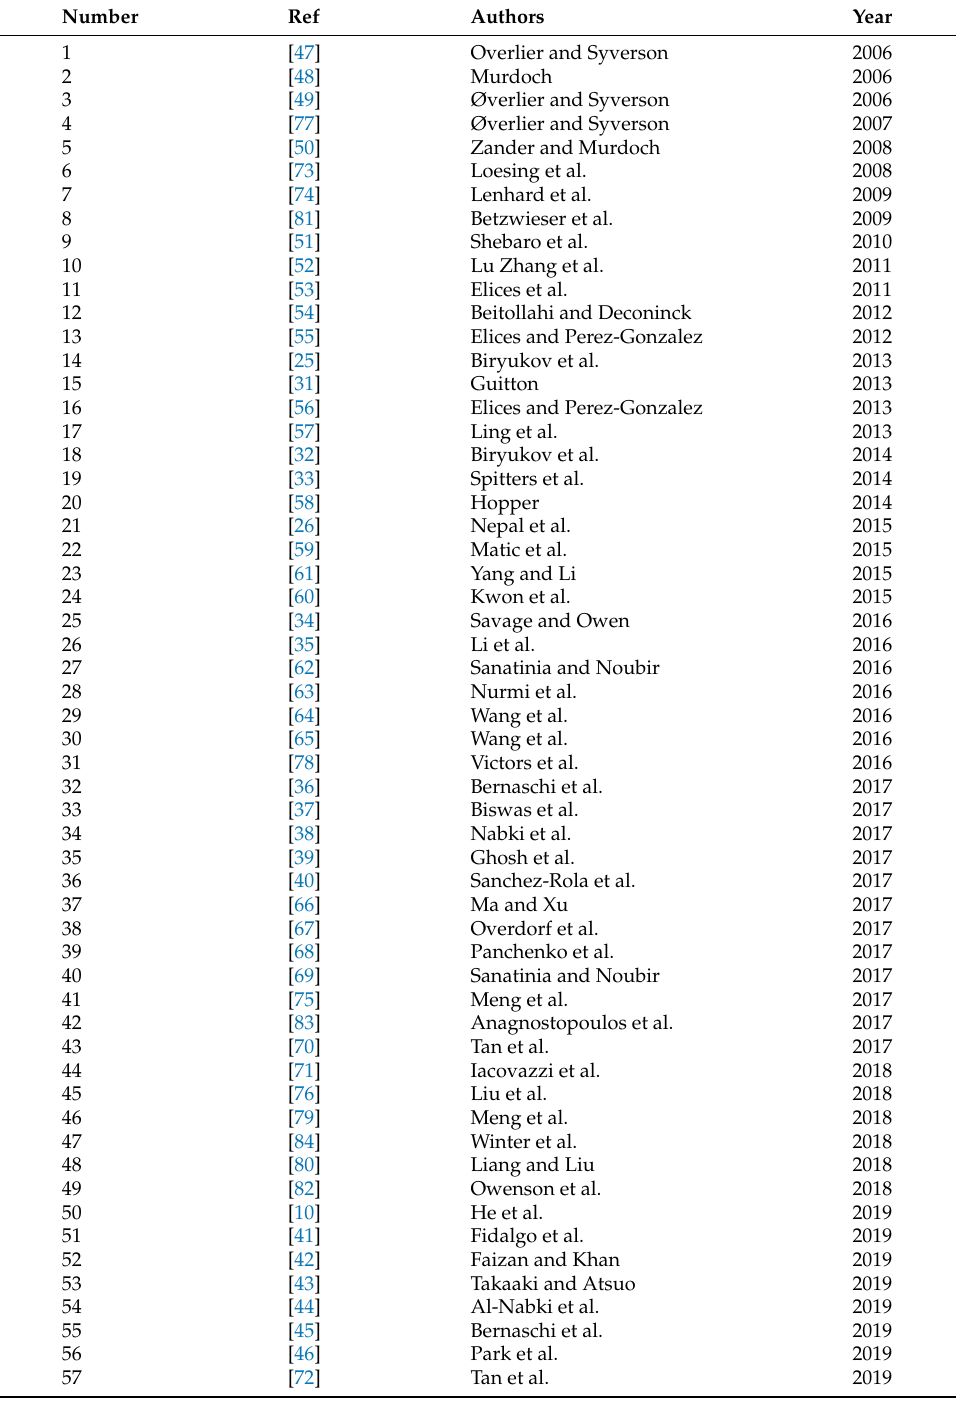
Table A1. List of all papers